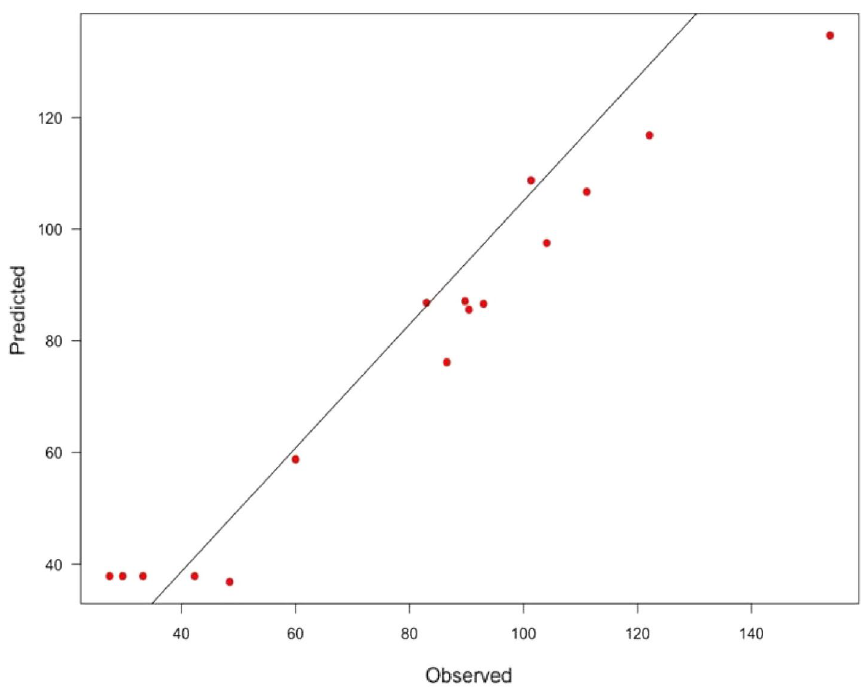
Figure 2. Graphical representation of the minimal difference between the actual (straight line) and predicted responses (circles) for the Response Surface Methodology Design for optimal xylanase activity.